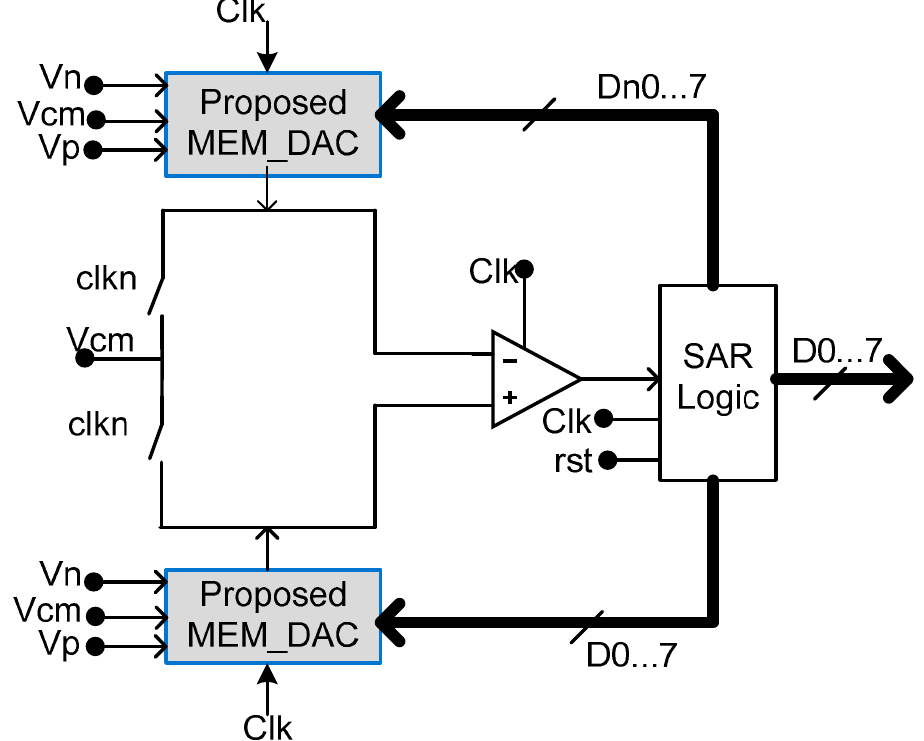
Figure 20. The proposed successive approximation register (SAR)-analog to digital converter (ADC) using memeristor DAC.